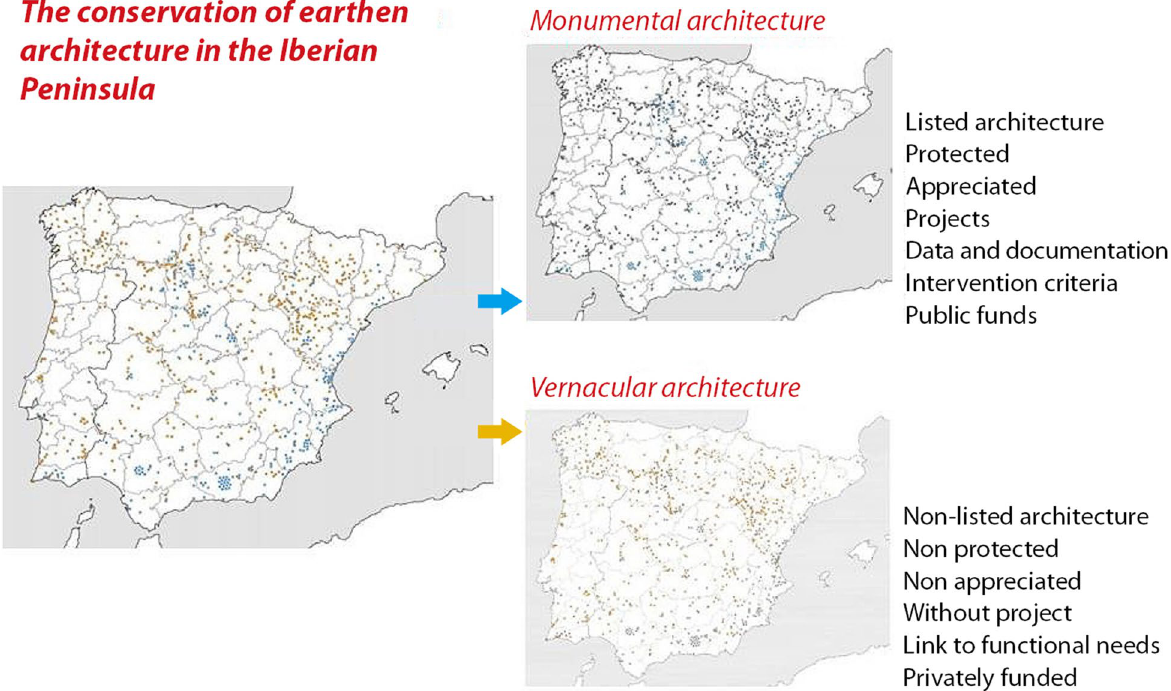
Fig. 1 The objective of these projects was to contribute to the valorisation of earthen architecture in the Iberian Peninsula, both monumental and traditional (Source: RES‑TAPIA & SOS‑TIERRA